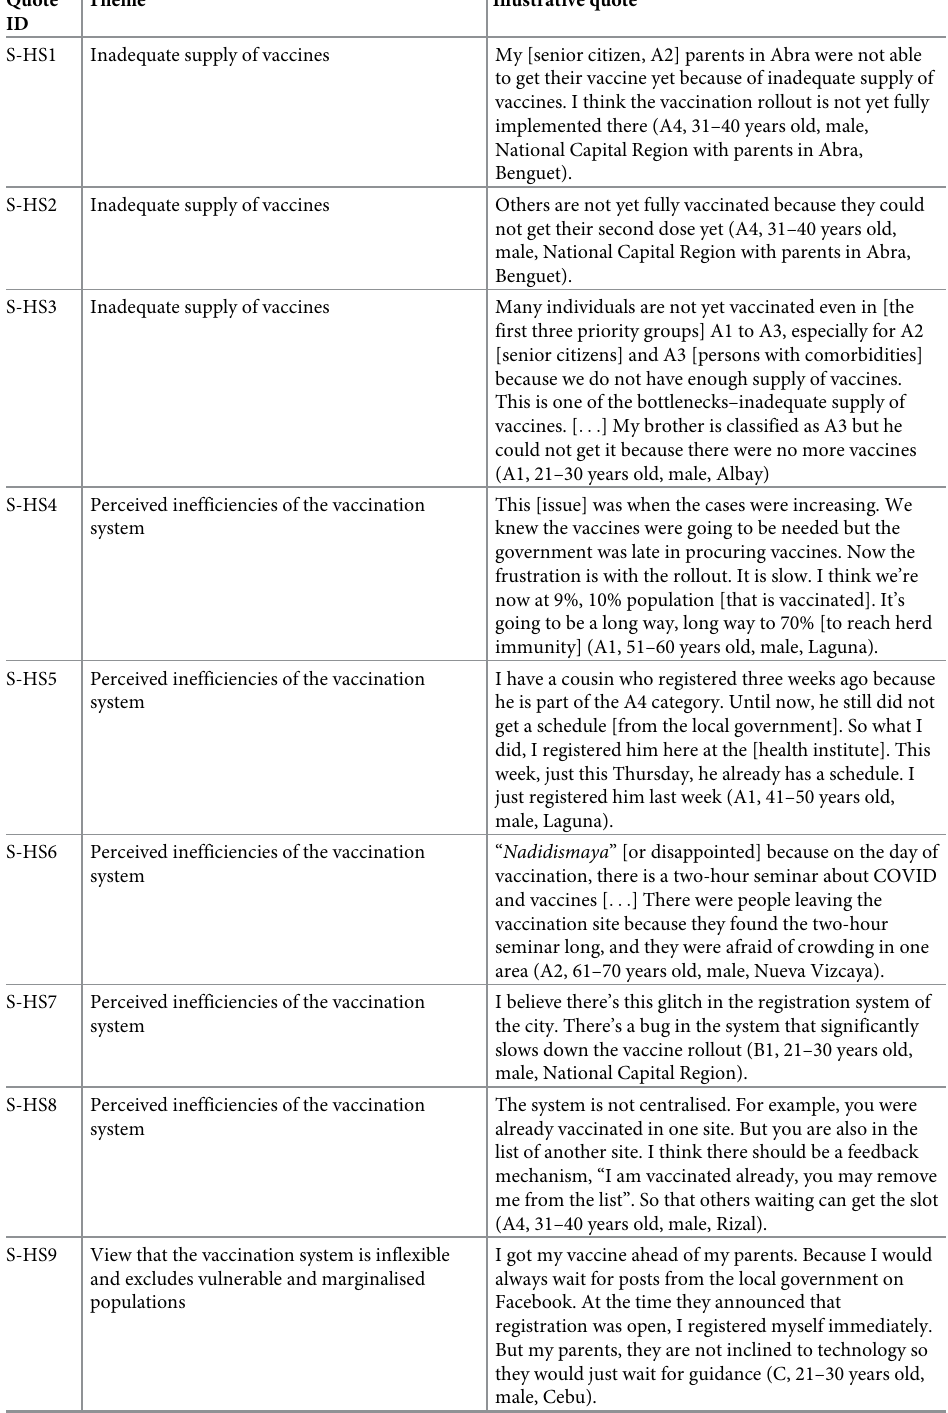
Table 5. Illustrative quotes for structural barriers relating to health systems and service